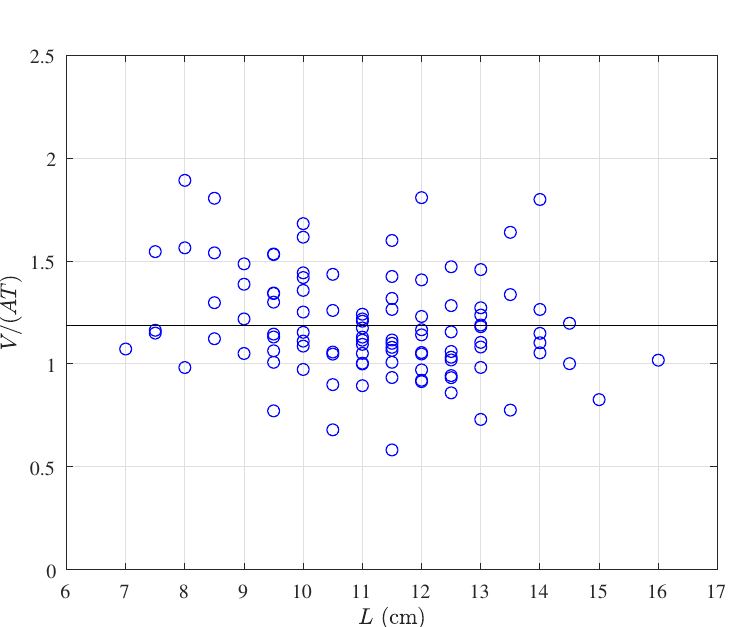
Figure 7. Measured volume of Asterias rubens normalized according to (4) as a function of length. The solid line corresponds to